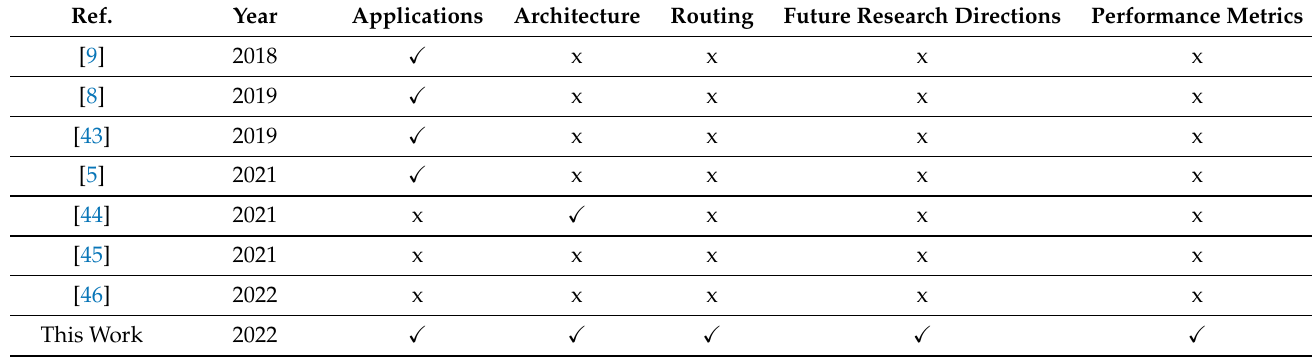
Table 1. Survey papers discussing the